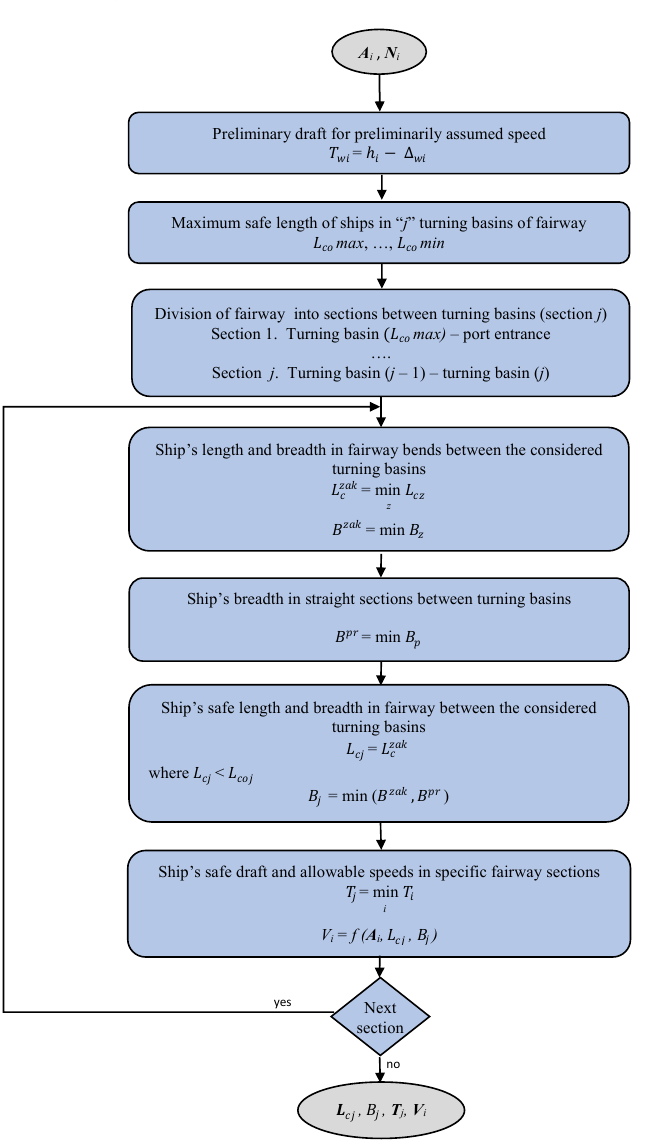
Figure 1. The algorithm of the process of determining maximum parameters of the ship in complex port waterways systems.